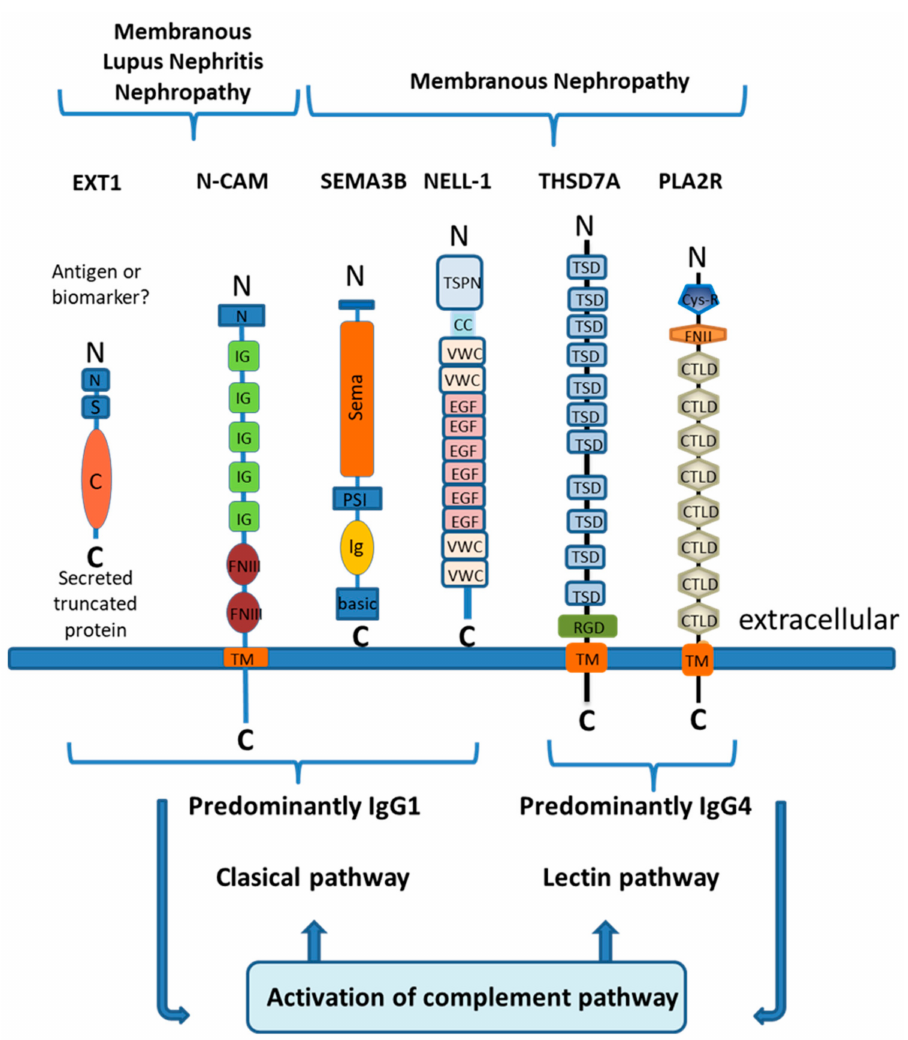
Figure 2. Antigens of membranous nephropathy and their schematic molecular structure.Exostosins are transmembrane proteins in the Golgi apparatus that have a short amino-terminal cytoplasmic tail (N), a single transmembrane domain (S), and a long globular catalytic C-terminal domain(C) within the Golgi lumen.NCAM1contains an amino-terminal tail (N), five immunoglobulin domains (IgG), two fibronectin type III domains (FNIII), a transmembrane domain (TM), and an intracellular region at the C terminal end.Sema3Bhas large Sema domain region, a plexin-semaphorin-integrin (PSI) domain, an Ig domain, and a short C terminal basic domain.NELL1 is characterized by an amino- terminal TSP-1-like (TSPN) domain, a coiled-coil (C-C) domain, two von Willebrand factor type C (VWC) domains, six EGF-like domains (E), and two VWC domains at the cytoplasmic end.THSD7A contains 11 trombospondin type-1 domains (TSD),an arginine-glycine-aspartic acid motif (RDG),a transmembrane domain(TM) and a C terminalintracellular end.PLA2R contains a cys-rich domain (Cys-R), a fibronectin type II domain (FNII),8 C-type lectin-like domains (CTLD),a transmembrane domain (TM), and a C terminal intracellular end. Shown is the predominant Ig subclass of the relevant antibodies and the main activated complement